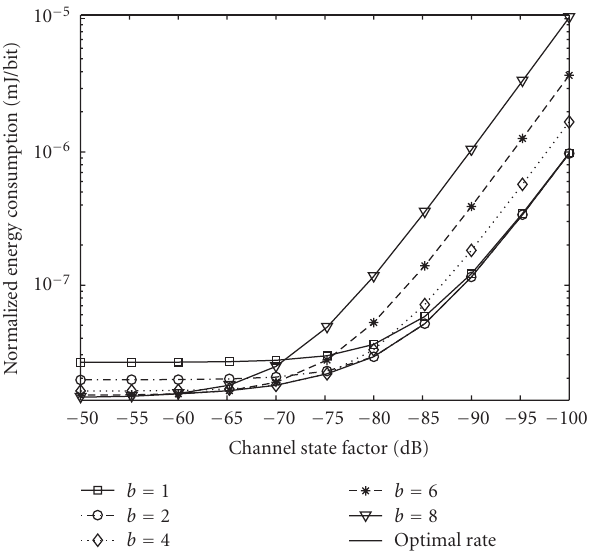
Figure 7: Normalized energy consumption in di ff erent channel conditions for di ff erent modulation schemes. Link layer fragmen- tation and payload are both 36 bytes, desirable BER is − 50 dB, and retry limit is 3.